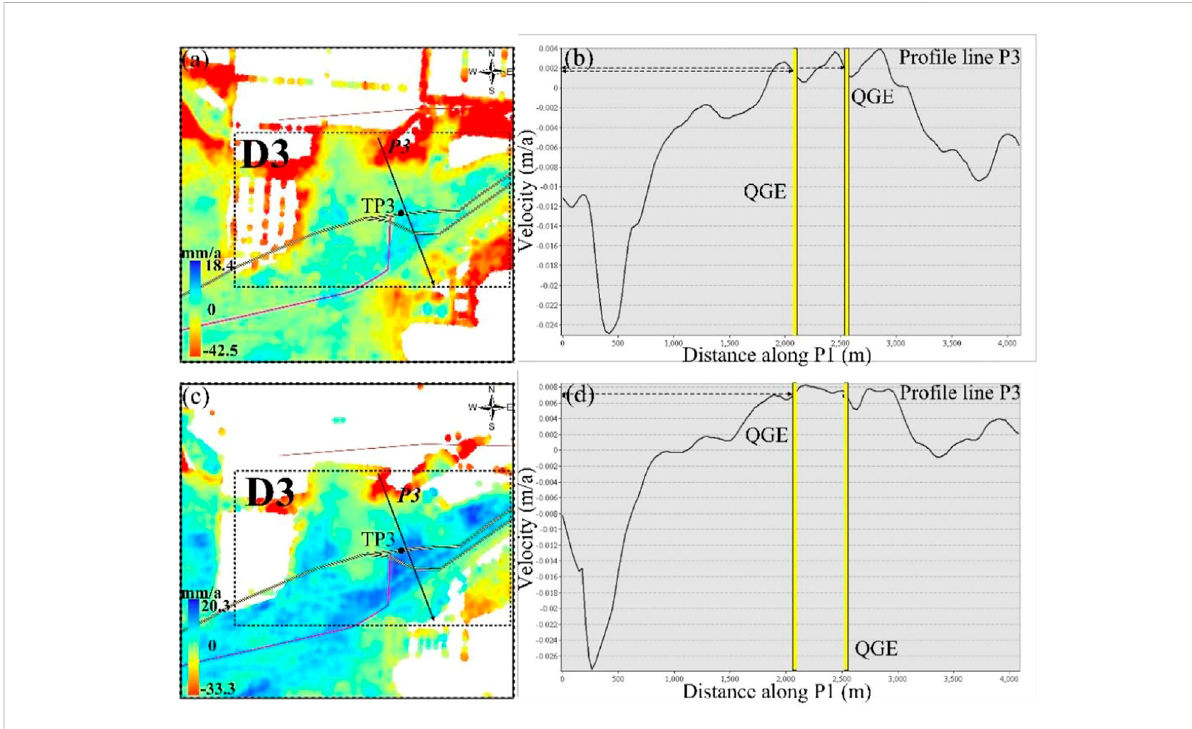
FIGURE 14 LargeversionLOSannualaveragedeformationvelocitymapfrom2018to2022ofareaD3andpro fi leline P3 . (A) and (B) indicatetheascending results, (C) and (D) indicate the descending results. The yellow trace represents the location of QGE along the pro fi le line.